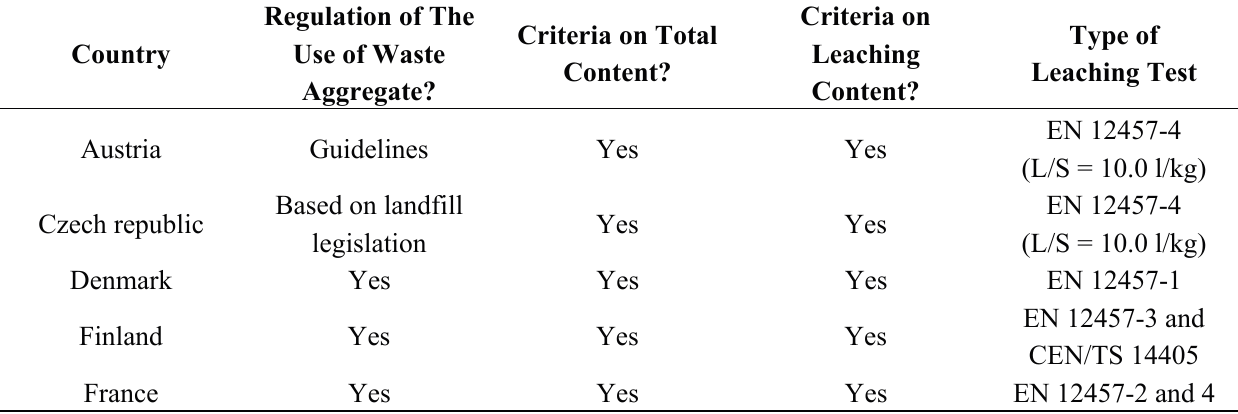
Table 1. Use of EU standard “EN 12457” in European countries, including variations in approaches to use and implementation